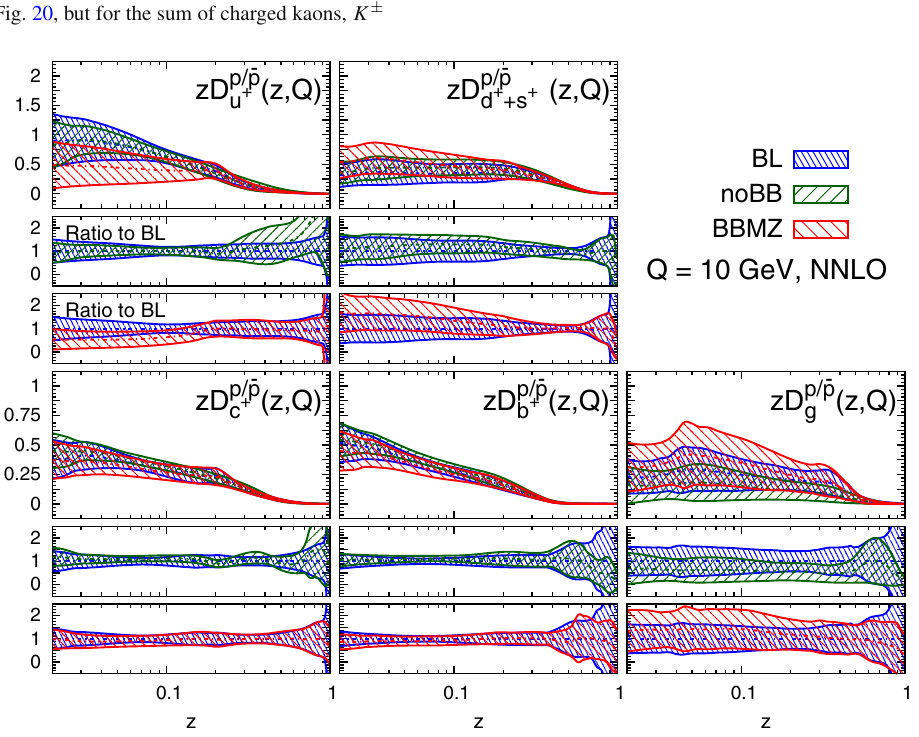
The gluon FFs is also affected. For pions and kaons, sig- nificant differences in shape are observed over the whole z range, while for protons/antiprotons only a small enhance- ment is seen when the BELLE and BABAR data are included.